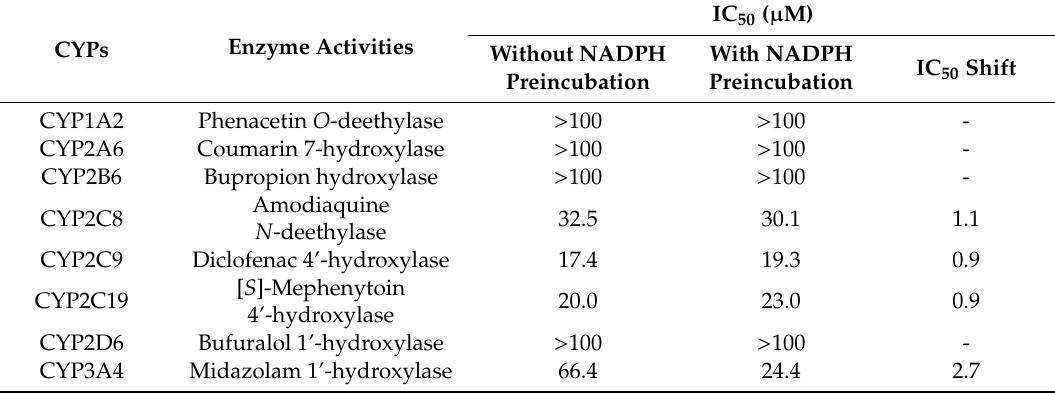
Table1. IC 50 valuesofindazolecarboxamidesyntheticcannabinoid(AB-PINACA)formajorcytochrome P450 (CYP) enzyme activities with and without 30-min preincubation with NADPH in ultrapooled human liver microsomes.